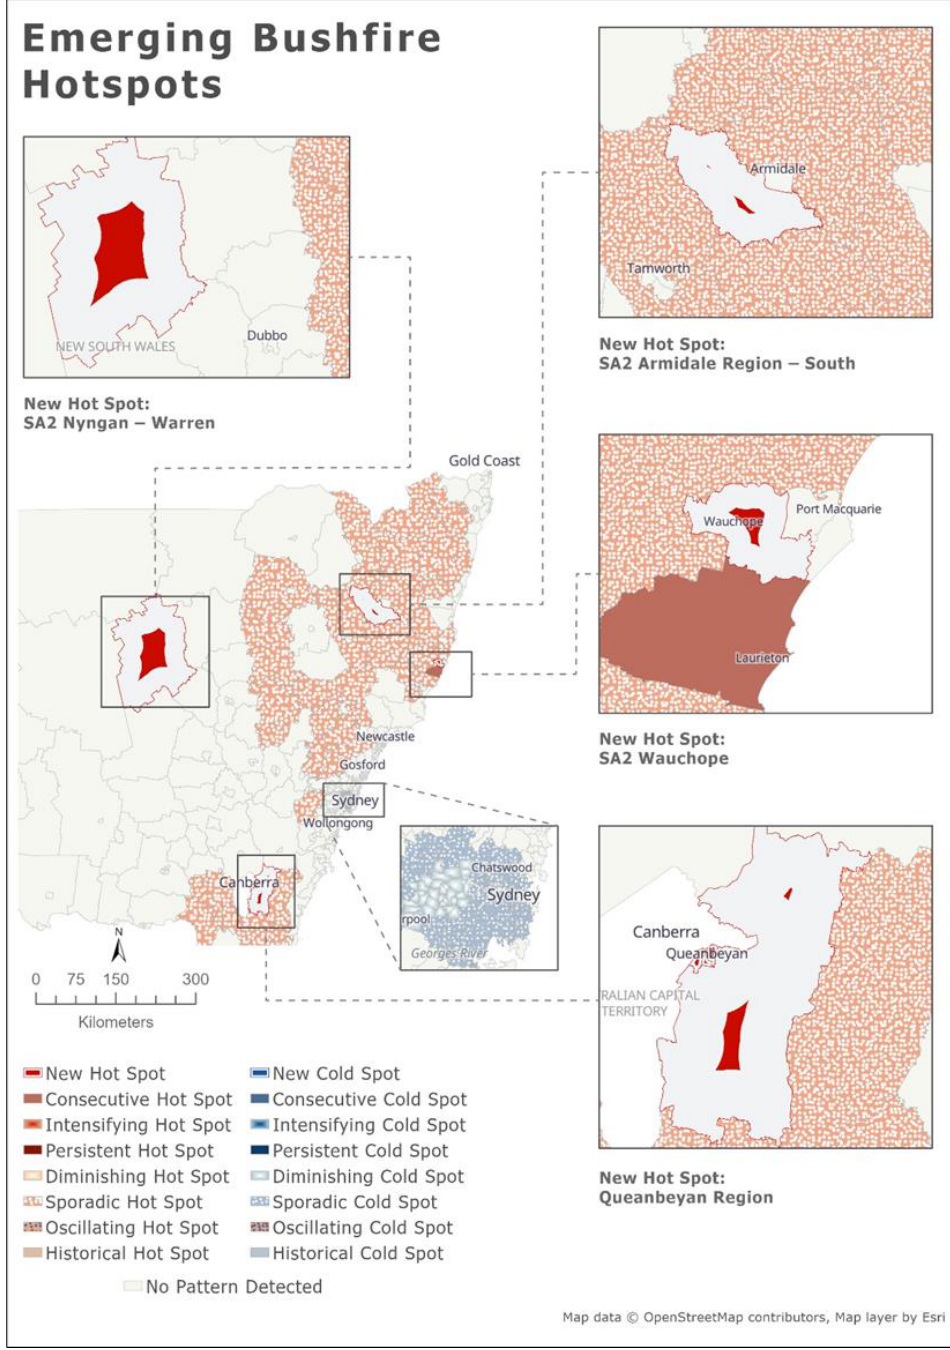
Figure 15. Spatial patterns over time of bushfire frequency for each NSW statistical area level 2.